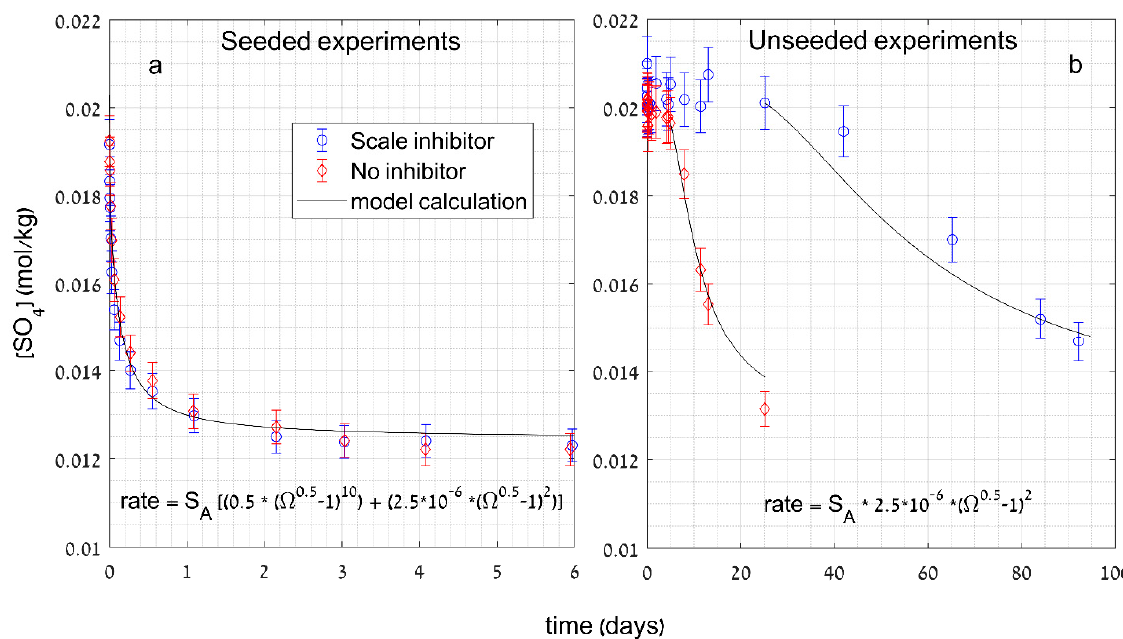
Figure 7. Measured (points) and model calculated (lines) concentration of SO 42 − in mixtures of Dead Sea brine with either evaporated seawater (no inhibitor) or reject brine (scale inhibitor) as a function of time. The calculations are from a forward model based on Equation (9). ( a ) Seeded mixtures. ( b ) Unseeded mixtures. Note the one order of magnitude difference in the time scales of the two graphs. Although all four mixtures have the same initial oversaturation, the equations describing the seeded experiments ( a ) have two terms while in those describing the unseeded mixtures ( b ) k far = 0, i.e., in effect Equation (9) is reduced back to Equation (8) which has only one term. The difference in the change in concentration of SO 42 − with time in the unseeded experiments is due to the antiscalant’s effect on the properties of gypsum formed during nucleation (see Reiss et al. [39]). Figure reprinted from Reiss et al. [39] with permission from Elsevier.